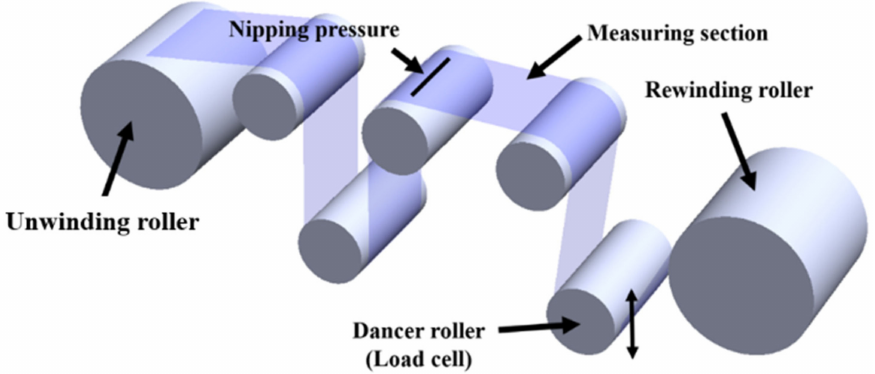
Figure 4. Schematic of equipment for web strain